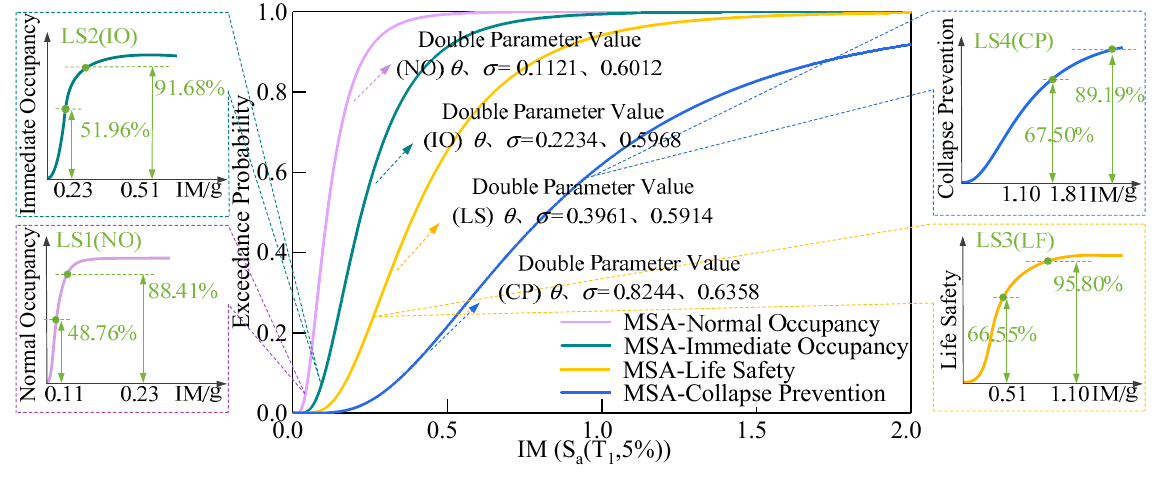
Figure 12. Fragility curves (MSA).